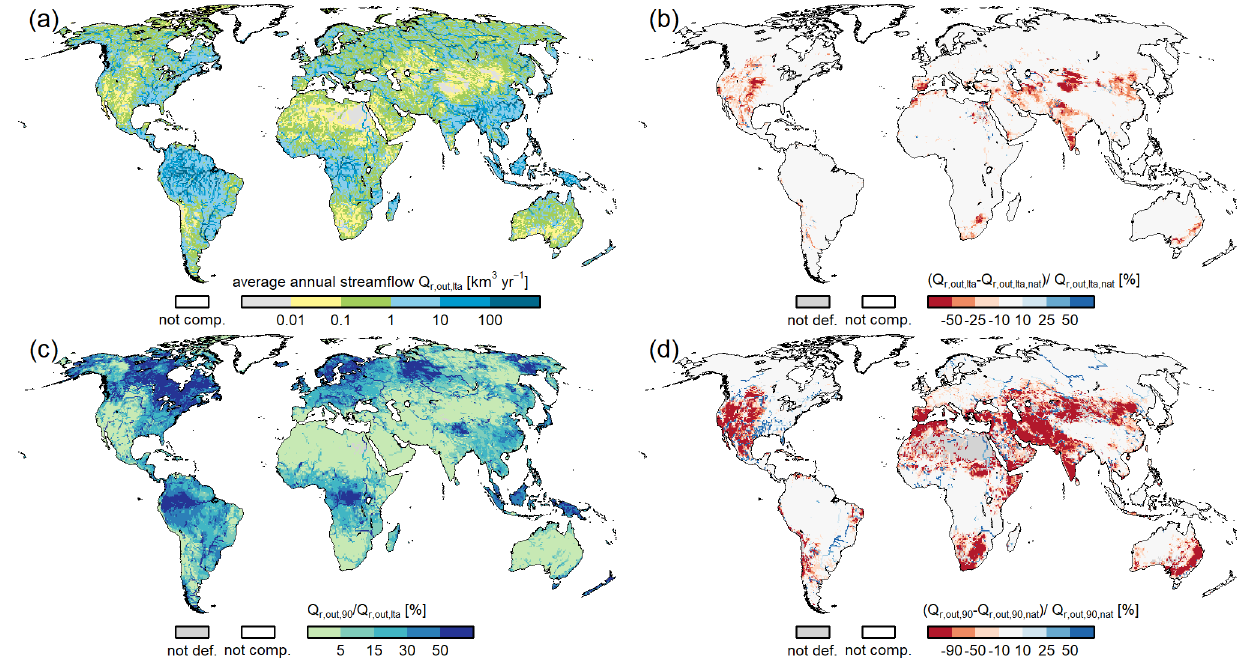
Figure 12. Streamflow indicators of WaterGAP 2.2d for 1981–2010 with (a) long-term average annual streamflow Q r , out , lta (km 3 yr − 1 ); (b) indication of streamflow alteration due to human water use and man-made reservoirs, where a reddish color indicates less streamflow for ant conditions, blue the opposite; (c) statistical monthly low flow Q r , out , 90 in percent of Q r , out , lta ; (d) differences of long-term average statistical monthly low flows as indication of low flow alteration due to human water use and man-made reservoirs. Not defined are areas where the denominator is smaller than 10 − 5 km 3 yr − 1 .